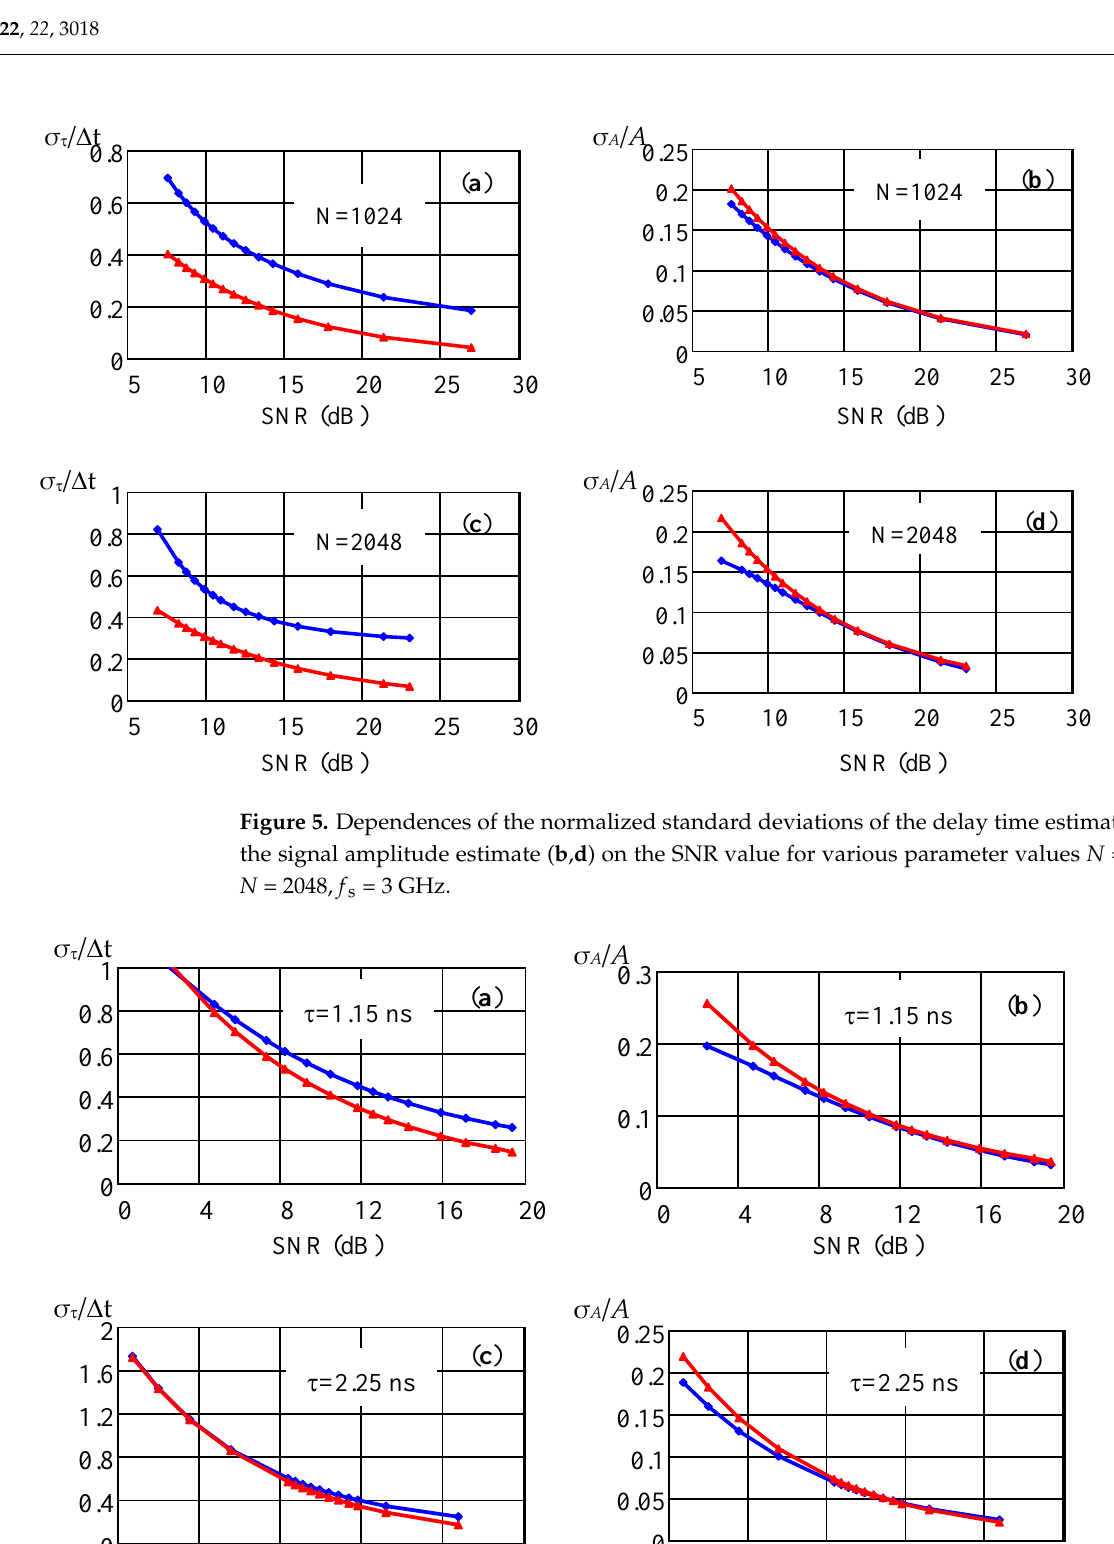
Figure 4. Implementation of the input signal x ( t ) ( a ) and the output signal of the estimator ( b ).